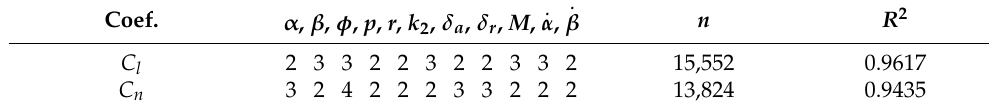
Table 3. Final main models of lateral-directional aerodynamics.